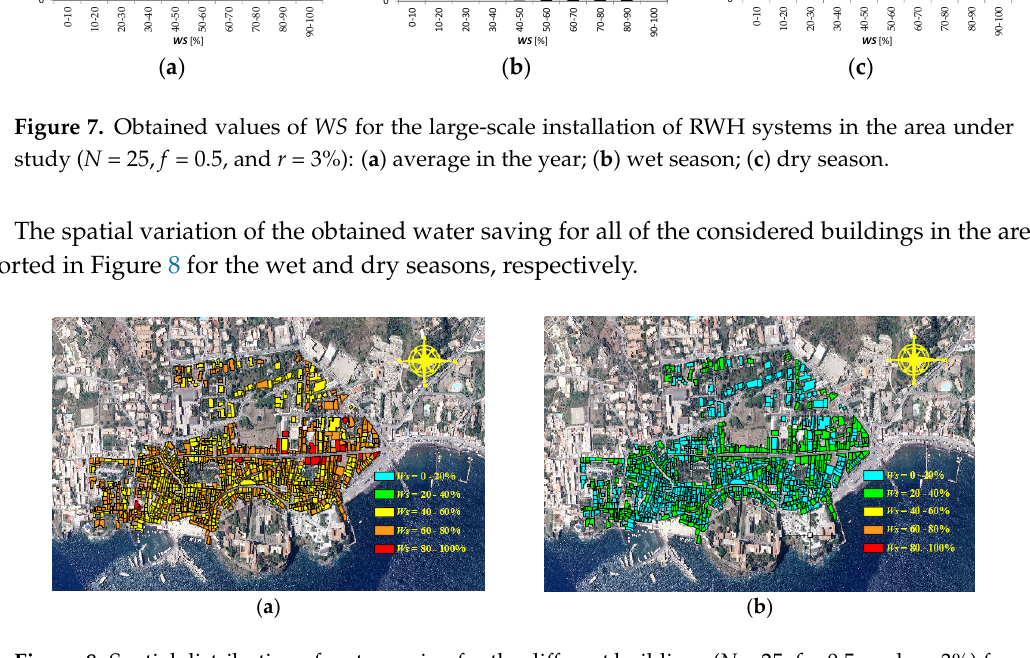
Figure 8. Spatial distribution of water saving for the different buildings ( N = 25, f = 0.5, and r = 3%) for: ( a ) wet season; ( b ) dry season.